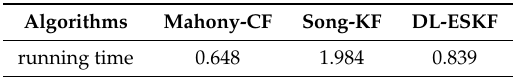
Table 10. Mahony-CF, Song-KF, and DL-ESKF running time(s) under dynamic